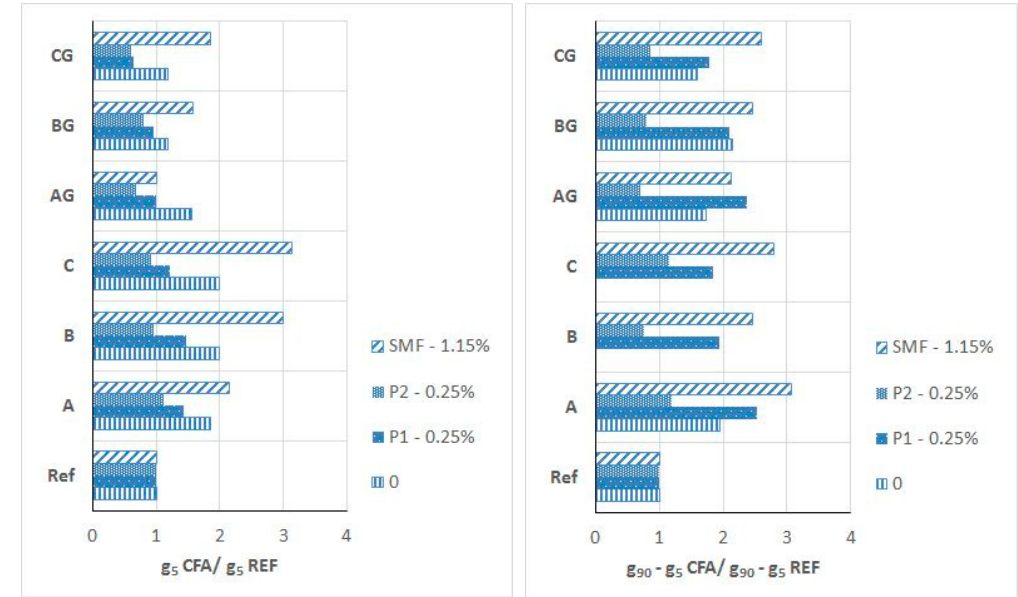
Figure 16. Relative effect of CFA presence on initial yield value g (g5) and yield value g increase in time (g90–g5) of mortars in respect to reference mortars REF without CFA (Mortars without and with P1 or P2 or SMF - ½ of recommended maximum dosage, w/b = 0.55).